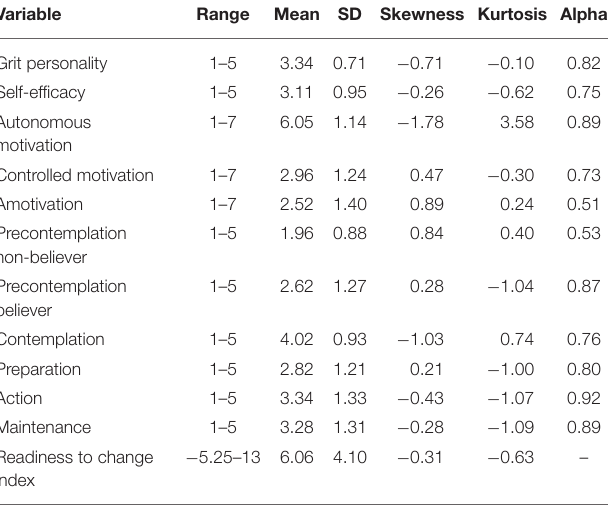
TABLE 1 | Descriptive statistics, and internal consistency, of the study variables.